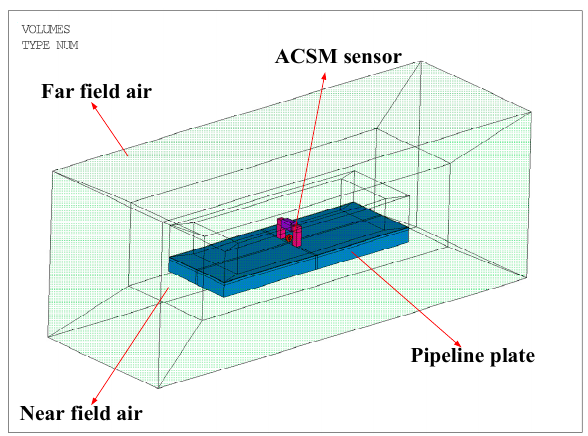
Figure 2. Overall 3D simulation model.